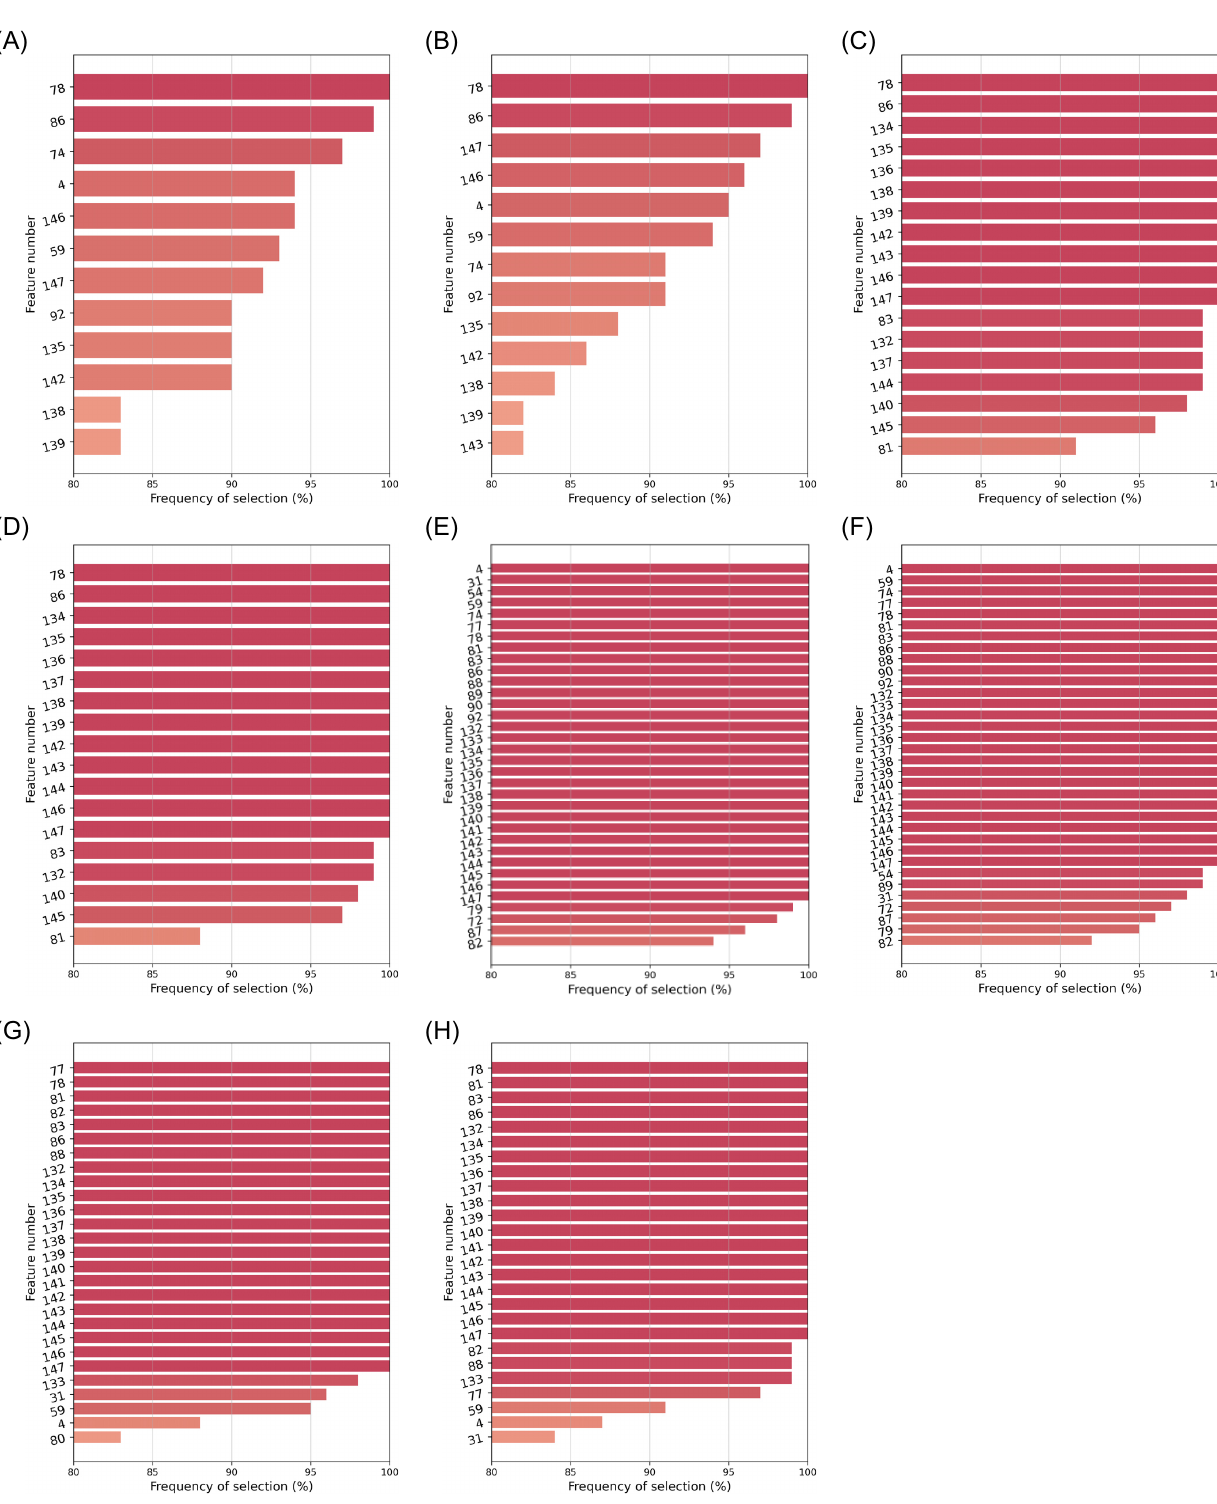
= 20 or 40. ( a ) MI Classif— k nn imputer: n FS